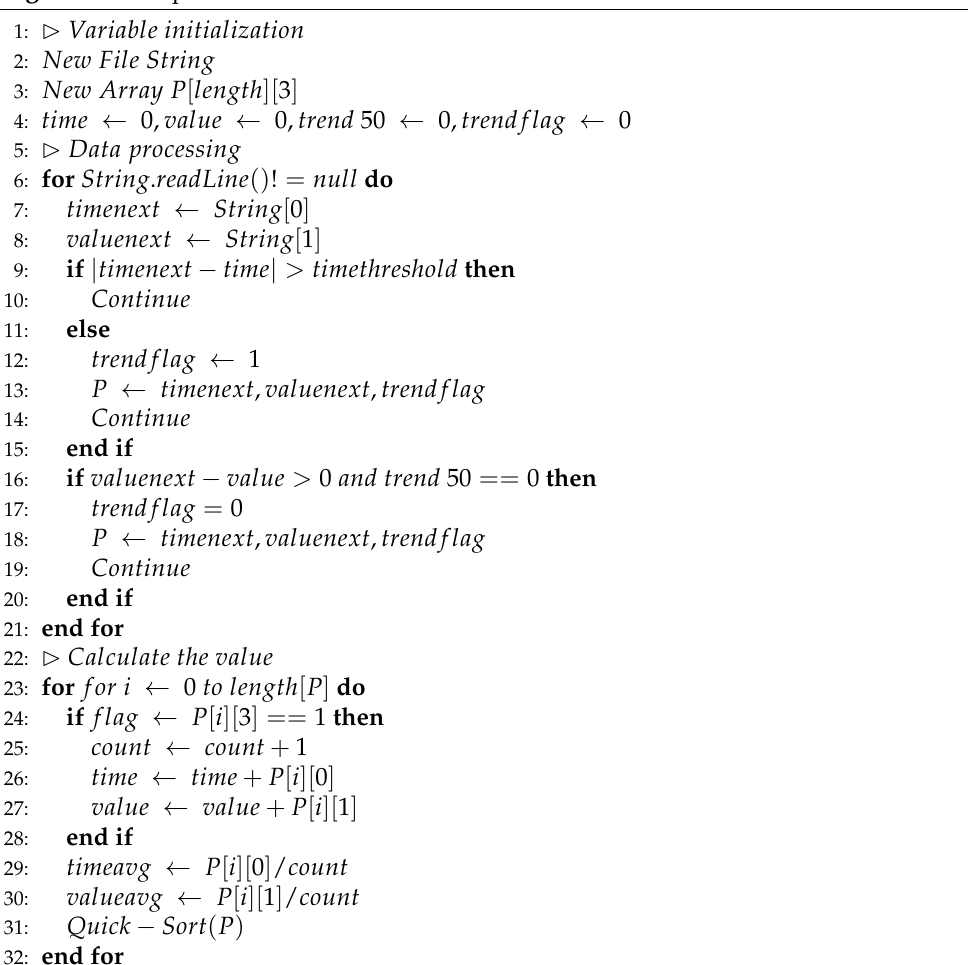
Algorithm 1 Capacitance